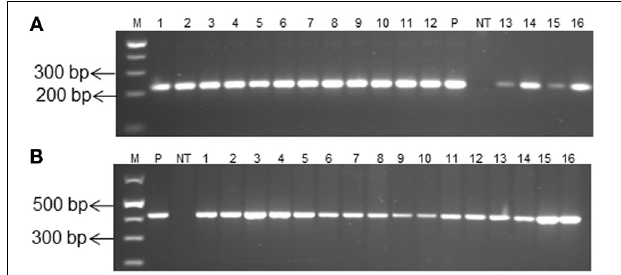
FIGURE 4 | PCR analysis of transgenic cassava lines using (A) gus A (B) hpt -specific primers. Lanes: M, molecular size marker (1kb plus DNA ladder); NT, non-transgenic plantlet DNA; P, pCAMBIA1301 plasmid DNA as a positive control; 1–8, 9–12, and 13–16, transformed cassava lines of cultivars 60444, Serere and Ebwanatereka,